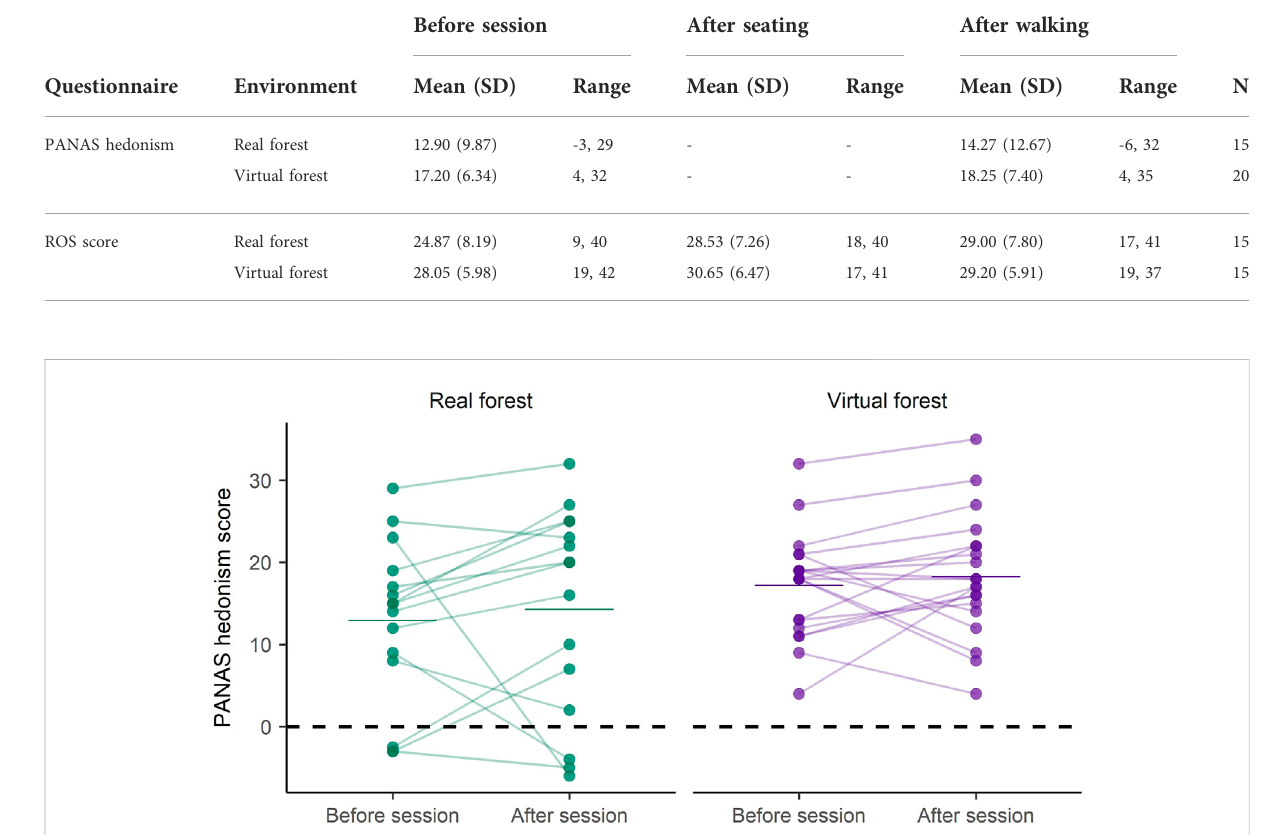
FIGURE 3 Individual change in participants ’ emotional state (PANAS hedonism score) split by virtual and real forest sessions. Each line represents an individual change, and horizontal lines in the graphs are mean values. The dashed horizontal line at 0 signi fi es a split between overall positive and negative emotions (above zero being overall